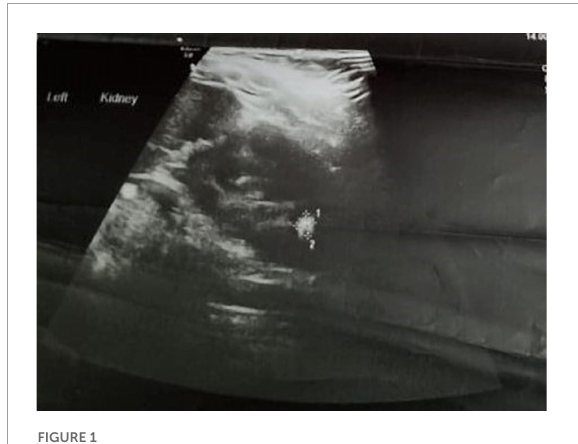
FIGURE1 Renal scan showing left renal pelvis of 13 mm with a 2 cm pelvic stone.